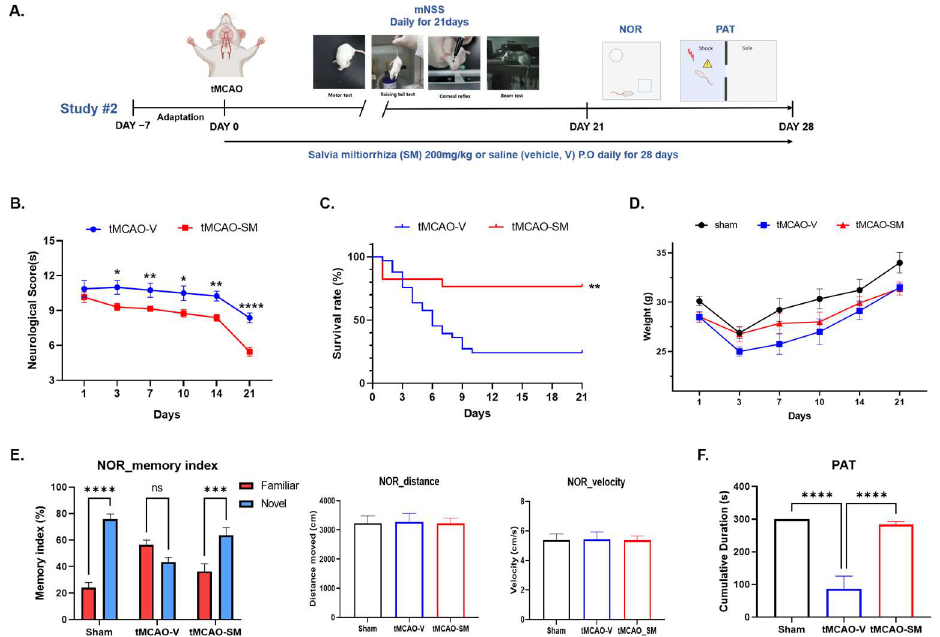
Figure 6. Experiment scheme and SM alleviate memory loss in tMCAO mouse model. ( A ) Experimental scheme. ( B ) Comparing neurological score (mNSS) between tMCAO-V and tMCAO-SM group at 1, 3, 7, 10, 14, 21 days after tMCAO induction (tMCAO-V, n = 8; tMCAO-SM, n = 13). Values are expressed as the mean ± SEM. Statistical analysis each day between two groups was performed using unpaired t test. ( C ) Probability of survival between tMCAO-V and tMCAO-SM group (tMCAO-V, n = 33; tMCAO-SM, n = 17). Values are expressed as the mean ± SEM. Statistical analysis was performed using Log-rank (Mantel-Cox) test. ( D ) Quantification of recovering body weight. ( E ) Data from NOR test and ( F ) PAT test were analyzed. (Sham, n = 9; tMCAO-V, n = 8; tMCAO-SM, n = 13). Values are expressed as the mean ± SEM. Statistical analysis between the three groups was performed using the two-way ANOVA following Bonferroni’s multiple comparisons test for NOR test and one-way ANOVA following Tukey’s multiple comparisons test for PAT test. * p < 0.05, ** p < 0.01, and *** p < 0.001, and **** p <